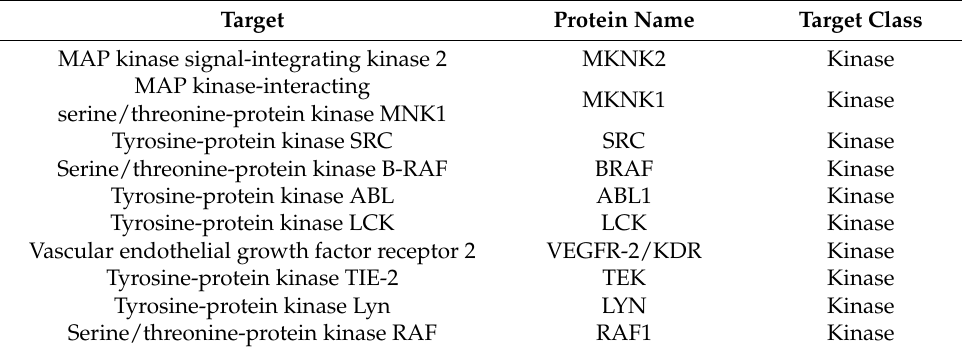
Table 1. Top 10 predicted WS6 targets according to the SwissTargetPrediction tool. Full list can be found in Table